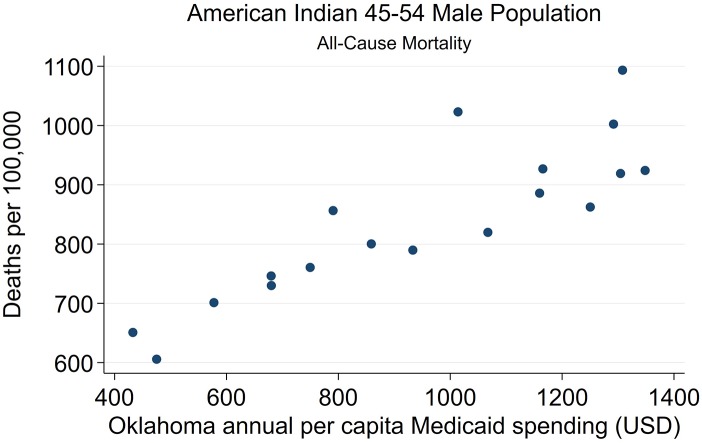
State-level Oklahoma Medicaid spending linear regression plot (crude association) with male AI45-54 all-cause mortality.